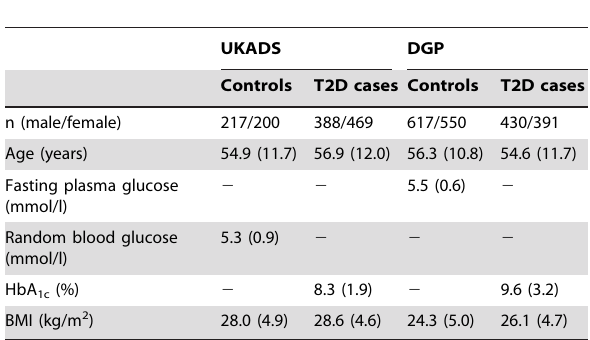
Table 1. Demographic and health characteristics of study participants in the two populations.